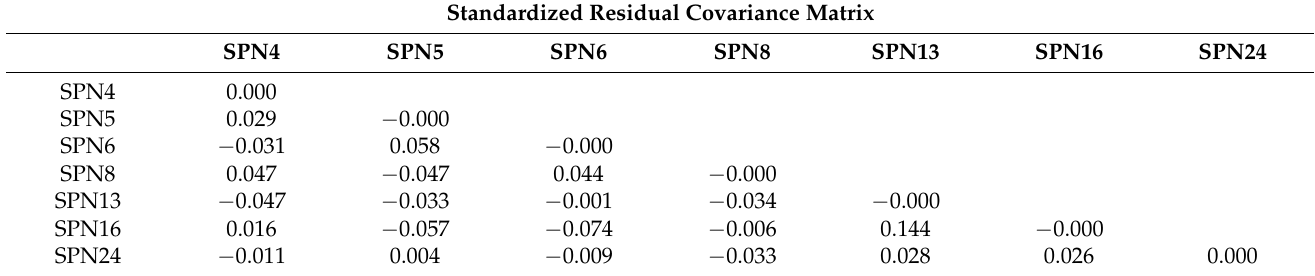
Table 9. Stakeholders participation (SPN) Model.